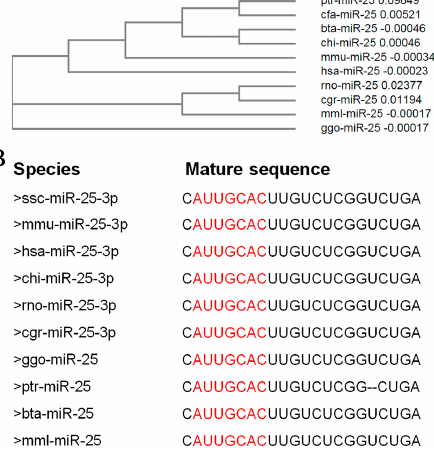
Figure 1. miR-25 is highly conserved in mammals. ( A ) The phylogenetic tree of pre-miRNA of miR-25. pre-miRNA sequences were obtained from NCBI. ( B ) The mature sequences of miR-25 in selected species. These mature sequences were obtained from miRBase. Seed regions are highlighted in red. ssc, sus scrofa; mmu, mus musculus; hsa, homo sapiens; chi, capra hircus; rno, rattus norvegicus; cgr, cricetulus griseus; ggo, gorilla gorilla; ptr, pan troglodytes; bta, bos taurus; mml, macaca mulatta; cfa, canis lupus